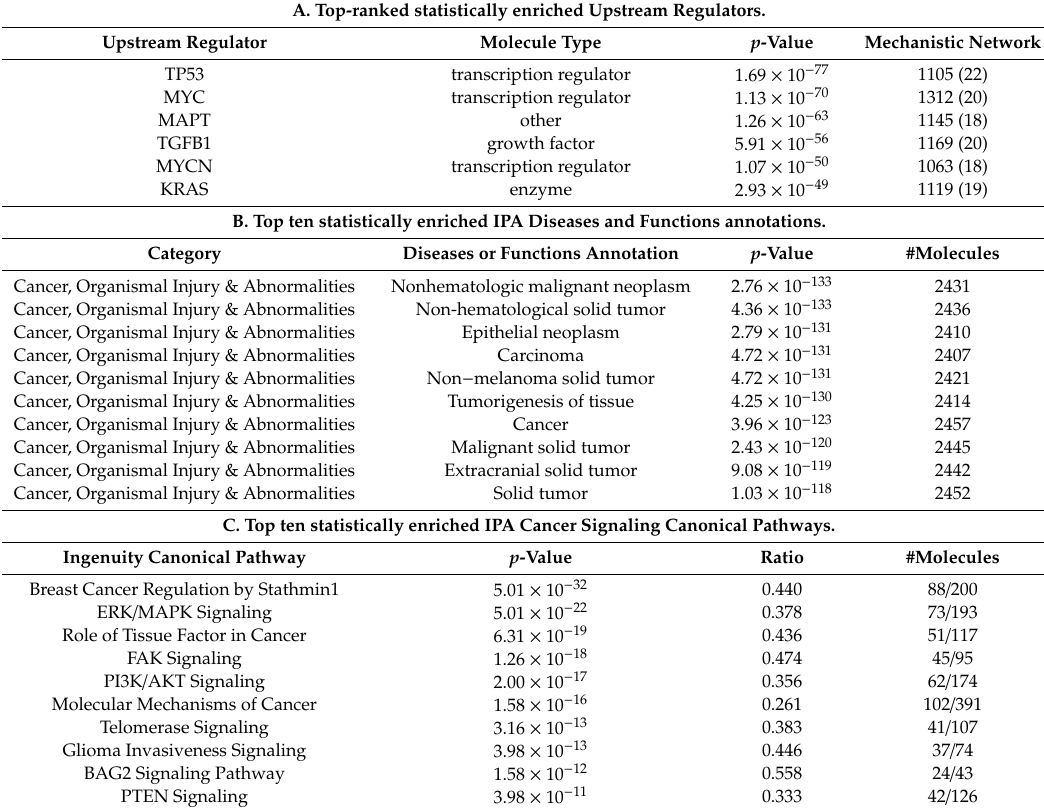
Table A2. Ingenuity Upstream Regulator, Diseases and Functions and Pathway Analyses of sEV protein features identified in two or more adenocarcinoma panel (LUAD and PDAC) cell lines with SA ≥ 2. A. Top-ranked statistically enriched Upstream Regulators.